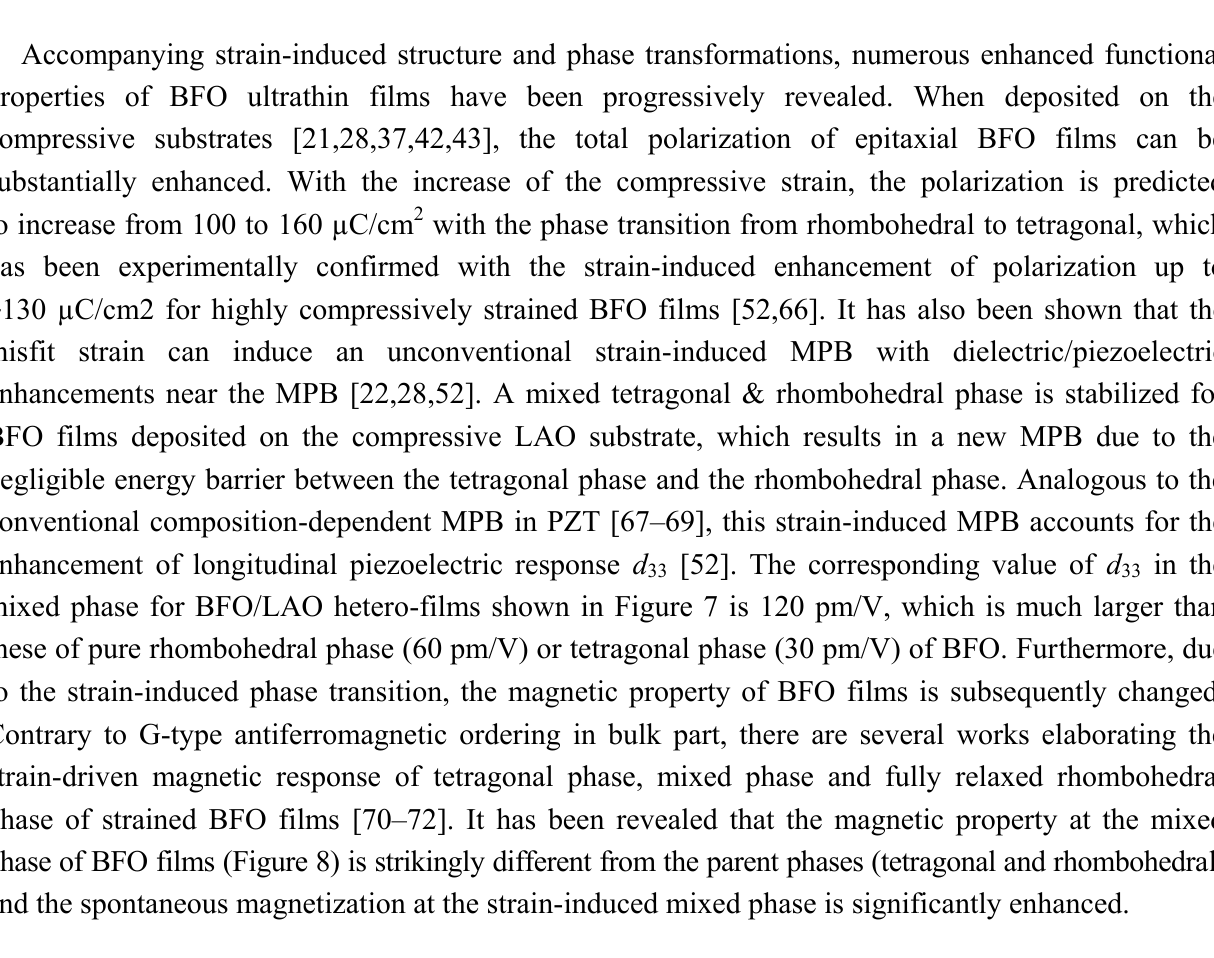
Figure 7. Piezoelectric hysteresis loops from T-like (blue curve), R-like (green curve) and mixed-phase (purple and red curves) BFO thin films. (Reprinted with permission from [52]. Copyright 2011 Macmillan Publishers